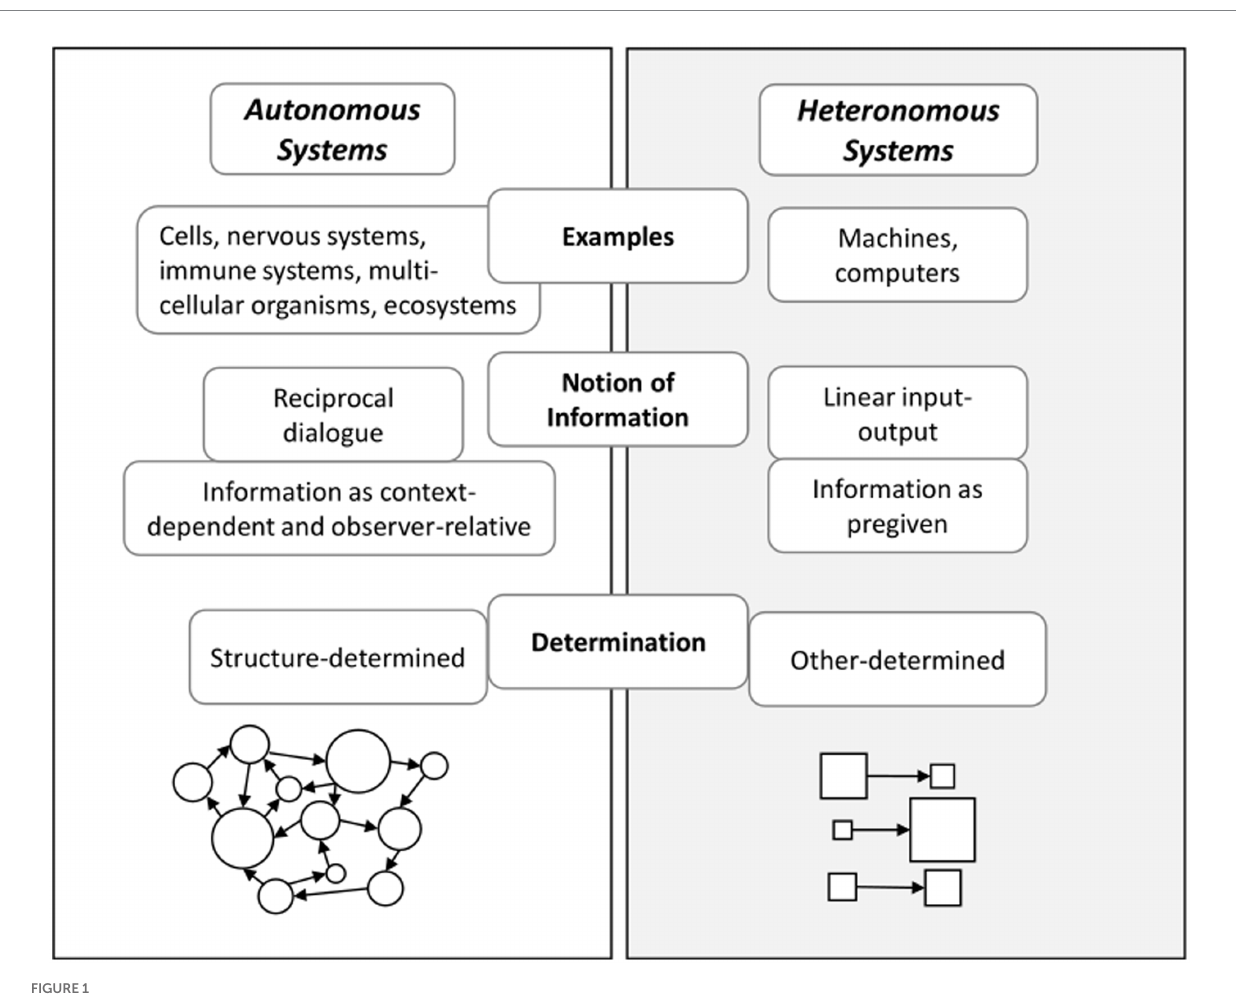
FIGURE 1 Autonomous systems in comparison to heteronomous